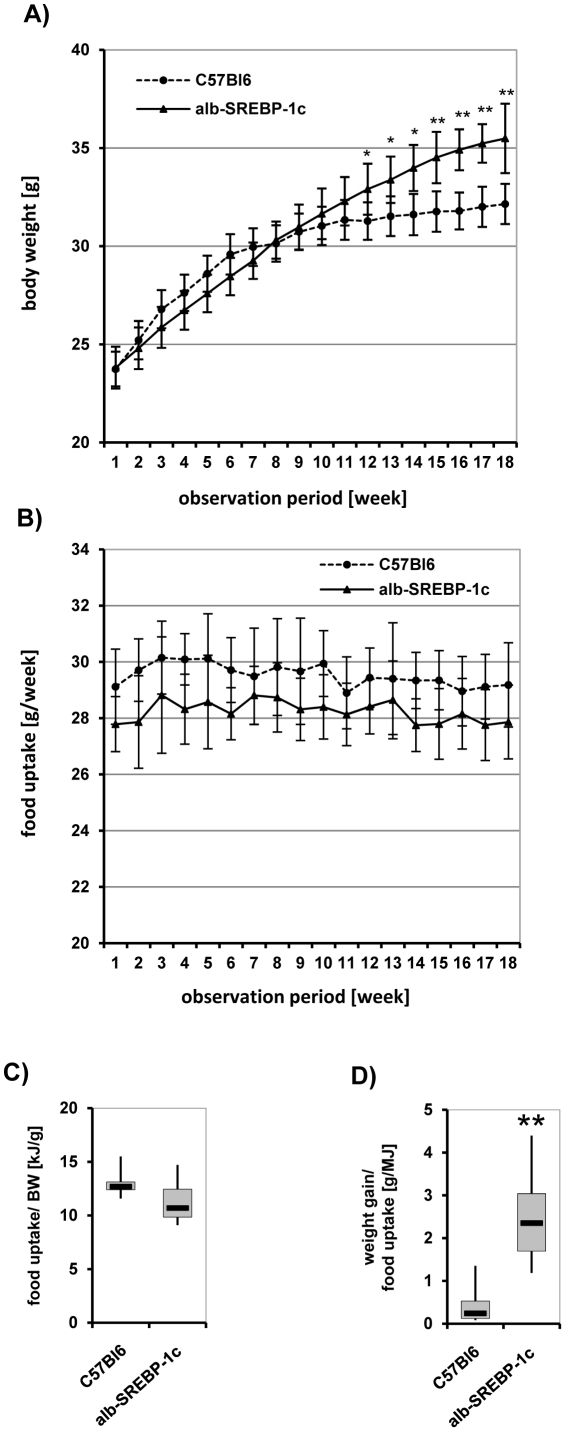
Phenotypical comparison of C57Bl6 and transgenic alb-SREBP-1c animals.Weight gain (A) and food intake (B) of male mice (n = 20 per genotype) were measured once a week starting at weaning and monitored for an observation period of 18 weeks. Food intake per body weight (C) and weight gain per food intake (D) were determined in each group of mice. Data are given as means including standard deviation (±S.D.). C57Bl6 vs. alb-SREBP-1c mice: **p<0.01.